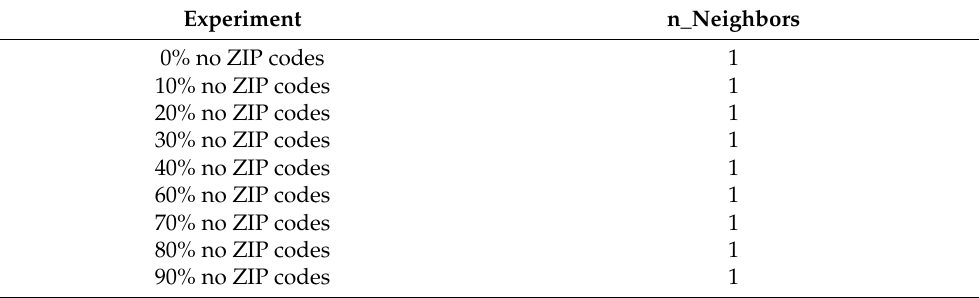
Table A1. Optimal hyperparameters for the kNN.